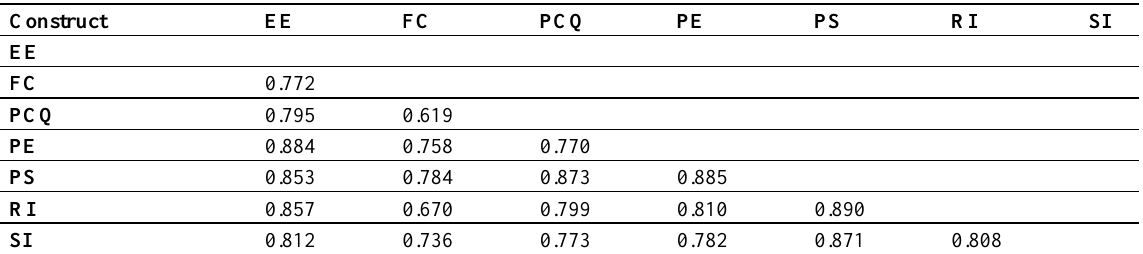
Table 4: Heterotrait-Monotrait Ratio (HTMT)